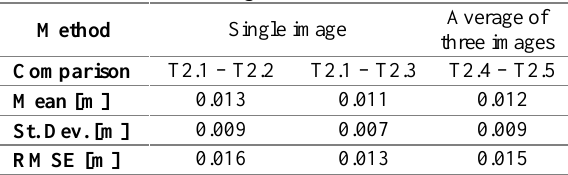
photogrammetric models using the same capture mode at different times without vegetation areas: the first two differences are related to the models obtained by single image capture mode, the last difference is related to the block acquired using the average of three images.